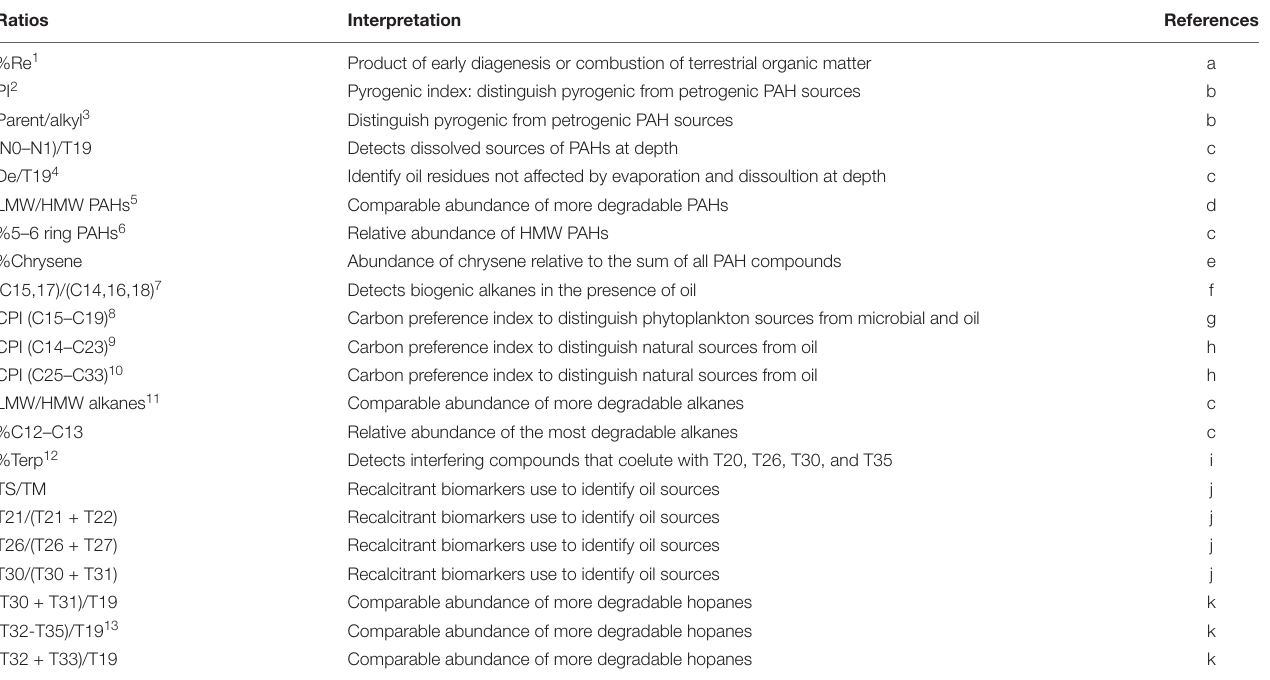
TABLE 1 | List of diagnostic ratios for PAHs, alkanes, and